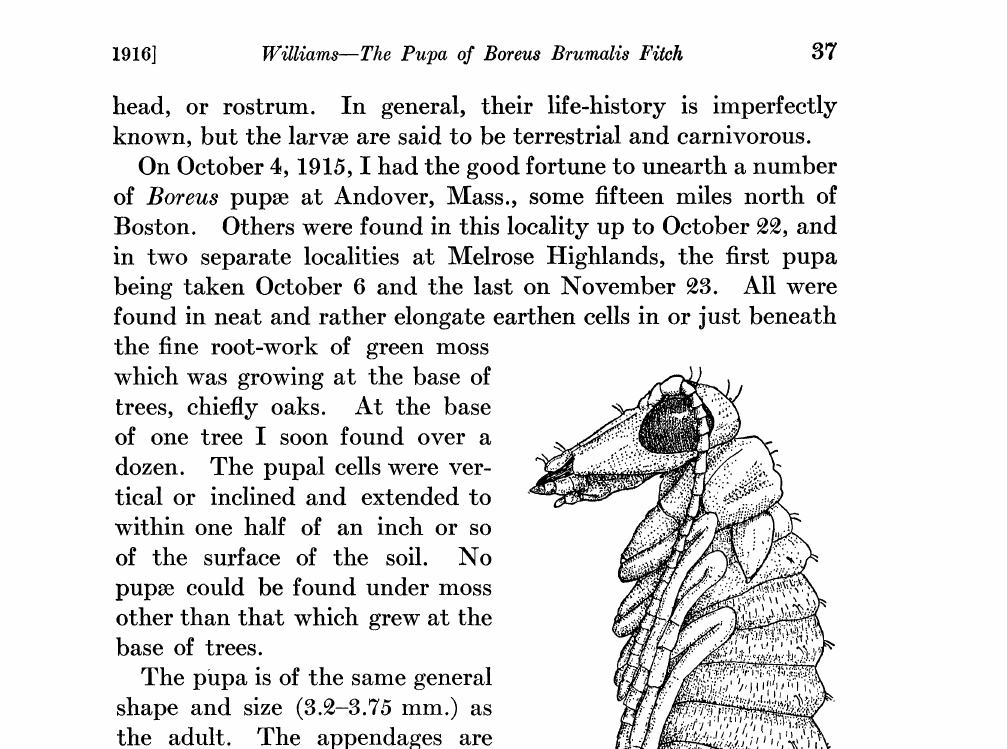
Fig. 1. Boreus brumalis, pupa.